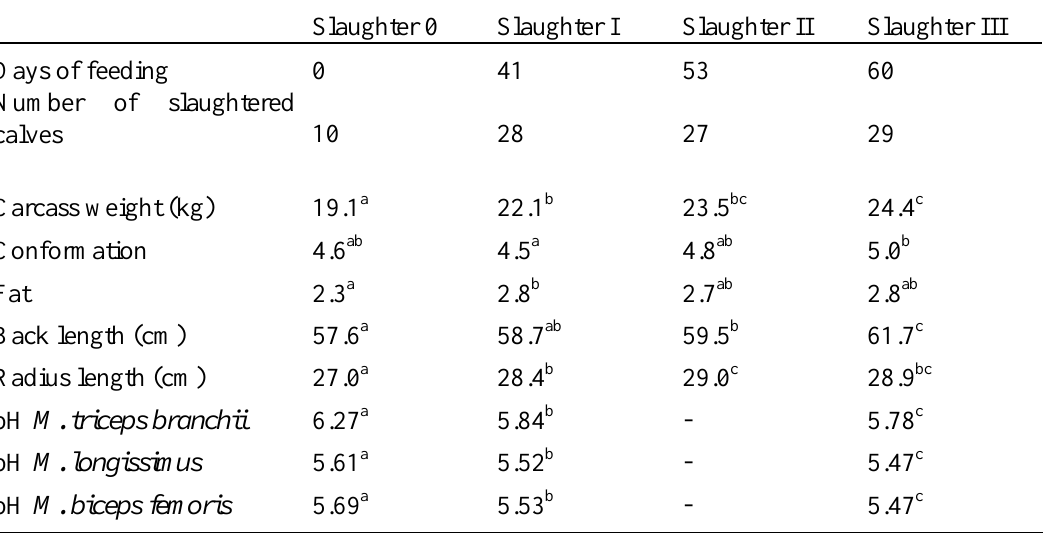
Table 1 . Results of registrations at slaughter for reindeer calves fed during different periods of time (Least Square